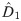
ABIDE data set: Distance contrast D^1 between the unweighted ASD and control connectomes for a threshold T = 0.8.